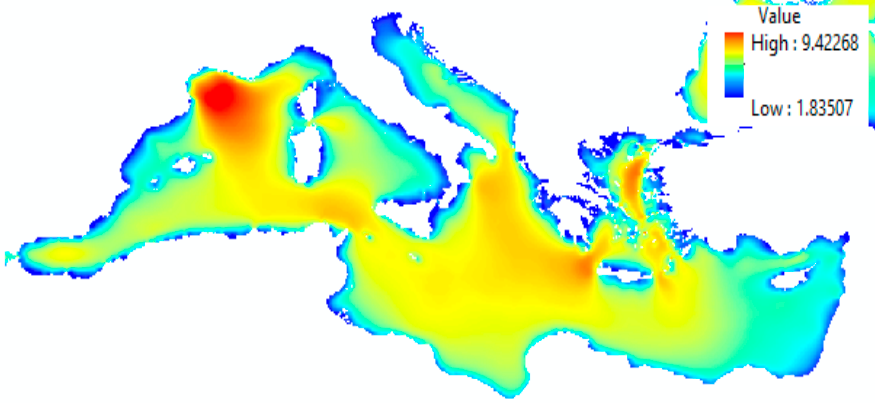
Figure 2. Mean wind speed (MWS) (m/s) with 10 m height in the Mediterranean Sea for the years from 2010 to 2017.